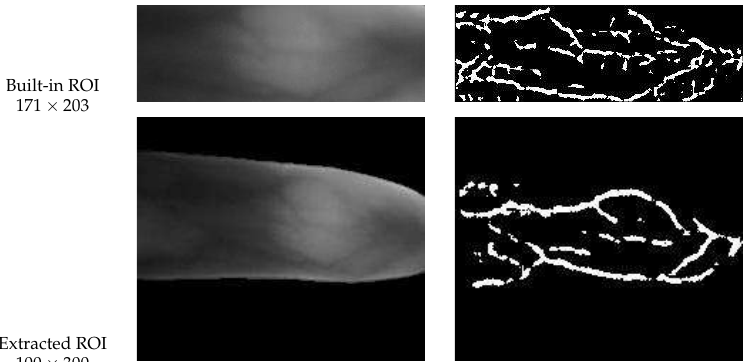
Figure 9. Sample diagram from FV-USM database, the first row is the built-in ROI image and its corresponding RLF-based vein feature, while the second row is derived from our adopted ROI localization strategy [62] and its corresponding RLF-based vein